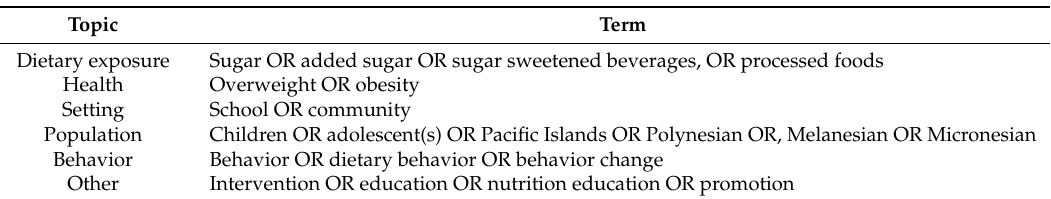
Table 1. Search terms used to generate relevant